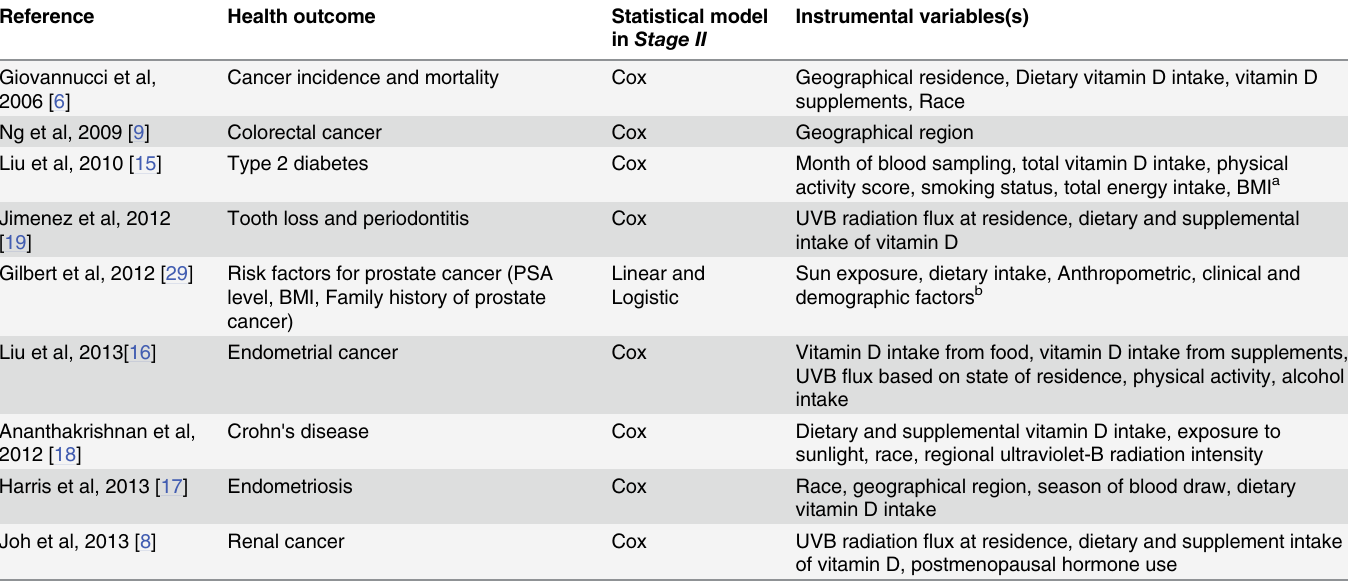
Table 1. Summary of papers employing predicted 25(OH)D score to examine associations between vitamin D status and health